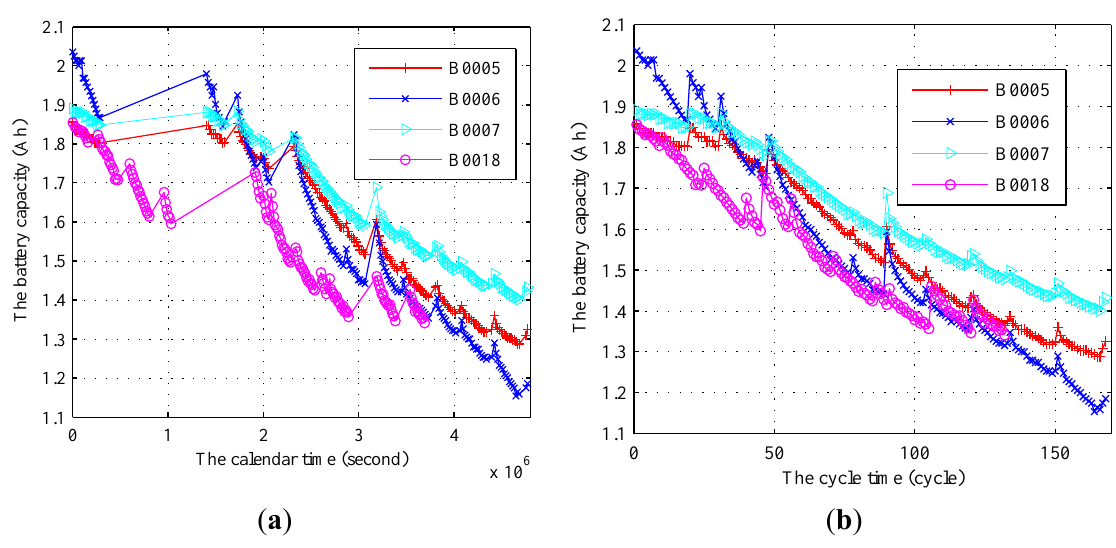
Figure 5. The experimental degradation data: ( a ) with calendar time; and ( b ) with cycle time.